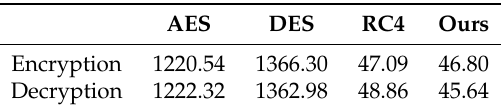
Table 4. Simulation results (ms).